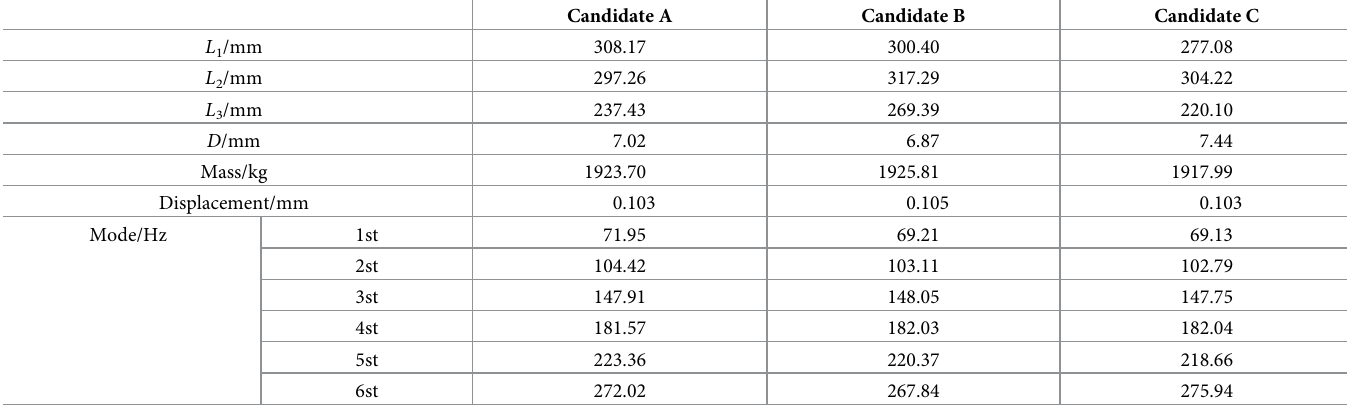
Table 5. Structural optimization for relatively optimal solutions.